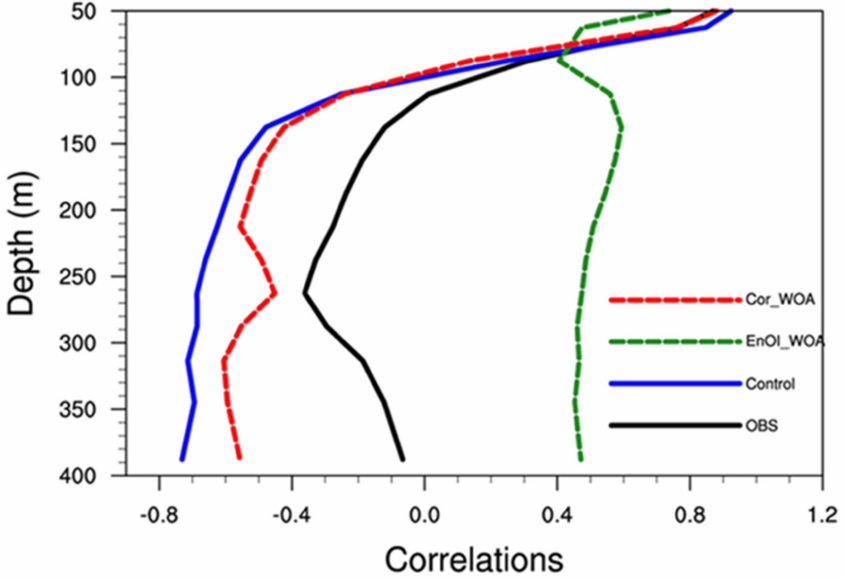
Figure 5. The correlation between SST and the upper 400 m sea temperature in the western tropical Pacific: black solid line, OBS; blue solid line, Control; green dashed line, EnOI_WOA; red dashed line,